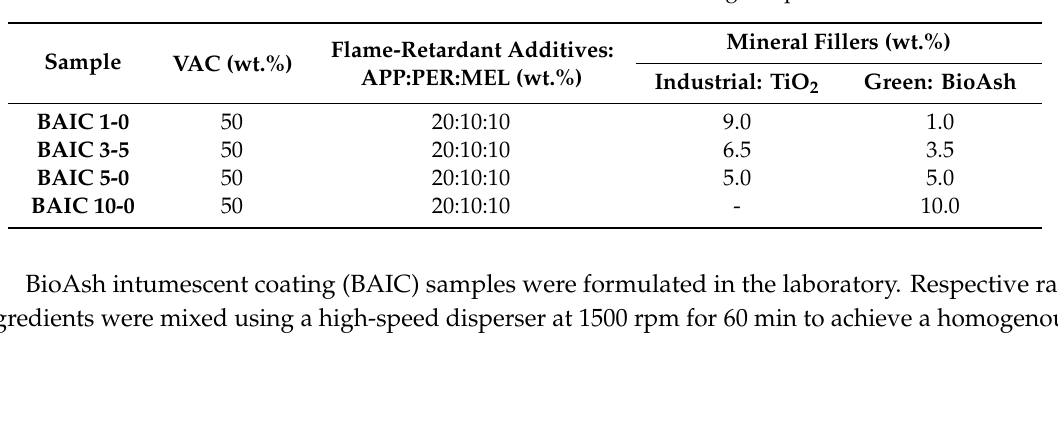
Table 1. Formulation of BioAsh intumescent coating